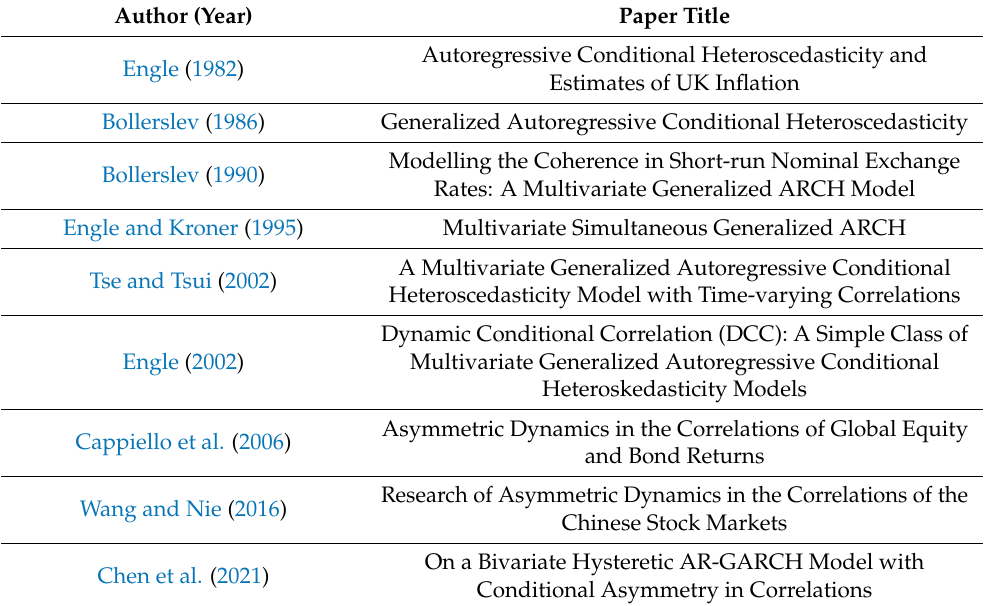
Table 2. Selected works on correlation/covariance and